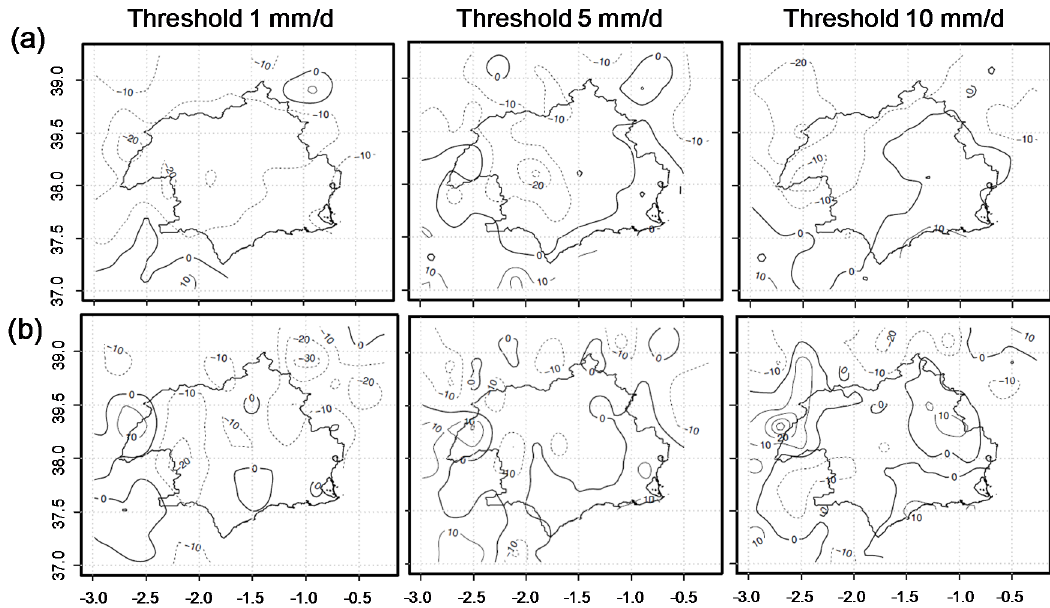
Figure 6. Spatial distributions of differences (Dif %) of μ , for different thresholds and Tr = 2 years: ( a ) Dif (1980–1950)/1950; ( b ) Dif (2007–1980)/1980. Significant differences are represented in solid gray, and dashed lines represent negatives